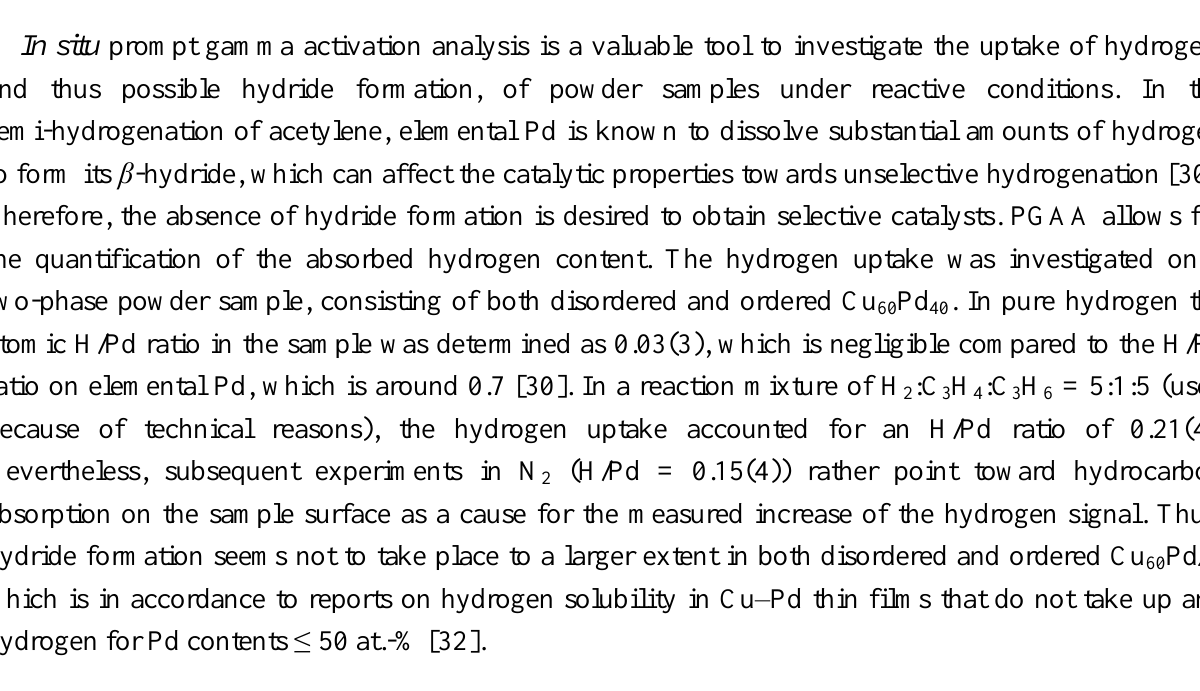
Pd ( a = 3.739 Å); ( c ) disordered Cu 60 40 Pd after catalysis. Stars indicate reflections of boron nitride used 60 40